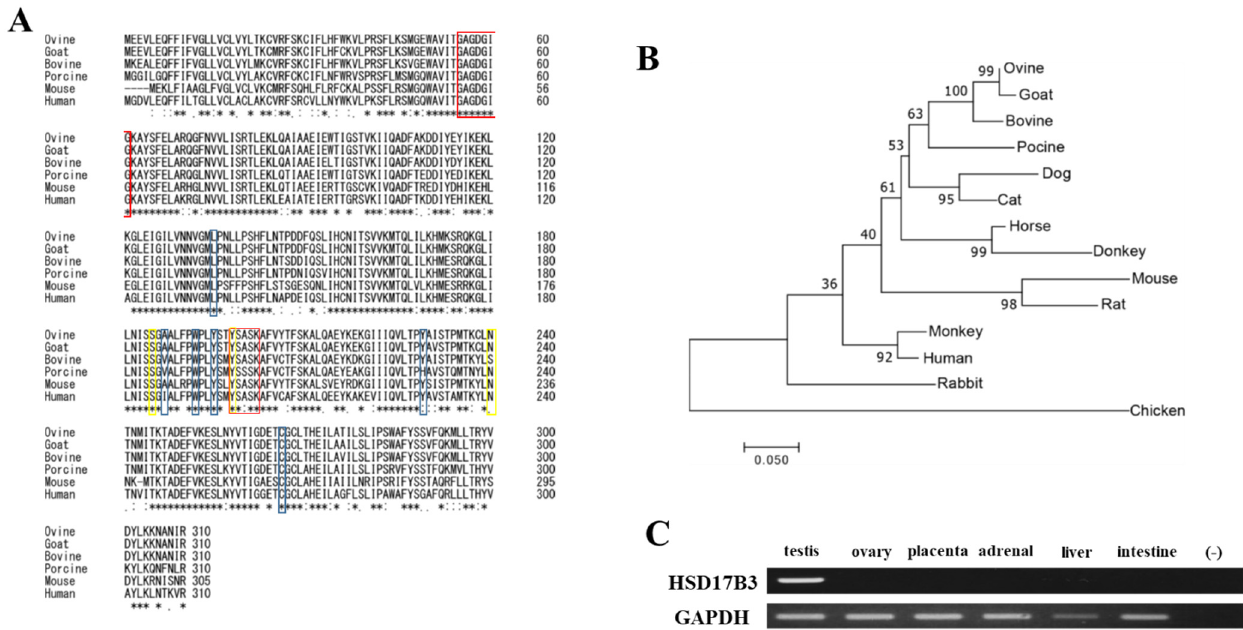
Figure 1. Alignment ( A ), phylogenic analyses ( B ), and tissue expression for ovine HSD17B3. ( A ) Alignment of the deduced HSD17B3 amino acid sequences of ovine, goat, bovine, porcine, mouse, and human. The asterix (*) are the conserved amino acids among all species. Conserved cofactor-binding motif (GXXXGXG) and active site (YXXXK) are shown by redline boxes. Putative amino acids for strong and weak androgen-binding are shown by the yellow line and blue line box, respectively. ( B ) The phylogenetic tree of HSD17B3 deduced amino acids. Bootstrap values (100 resamplings) are indicated by numbers. ( C ) Tissue expression of HSD17B3 genes. RT-PCR analyses of each gene in ovine testis, ovary, placenta, adrenal, liver, and intestine.